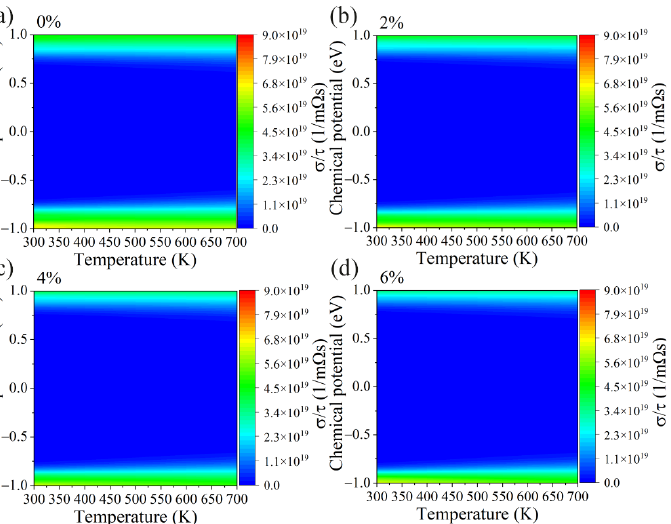
Figure 5. The contour map of the electrical conductivity divided by relaxation time ( σ / τ ) with respect to chemical potential under different biaxial tensile strains of ( a ) 0%, ( b ) 2%, ( c ) 4% and ( d ) 6% for GeS 2 monolayer.